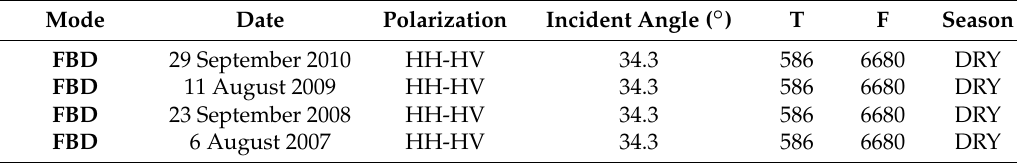
Table 2. Characteristics of the L-band Advanced Land Observation Satellite (ALOS) Phased Array L-band Synthetic Aperture Radar (PALSAR) used in the study. The datasets were acquired in Full Beam Dual (FBD) modes with Horizontal-Horizontal and Horizontal-Vertical (HH-HV) wave polarizations during dry seasons (DRY) between the years 2007 and 2010. T = Track, F = Frame. (source: